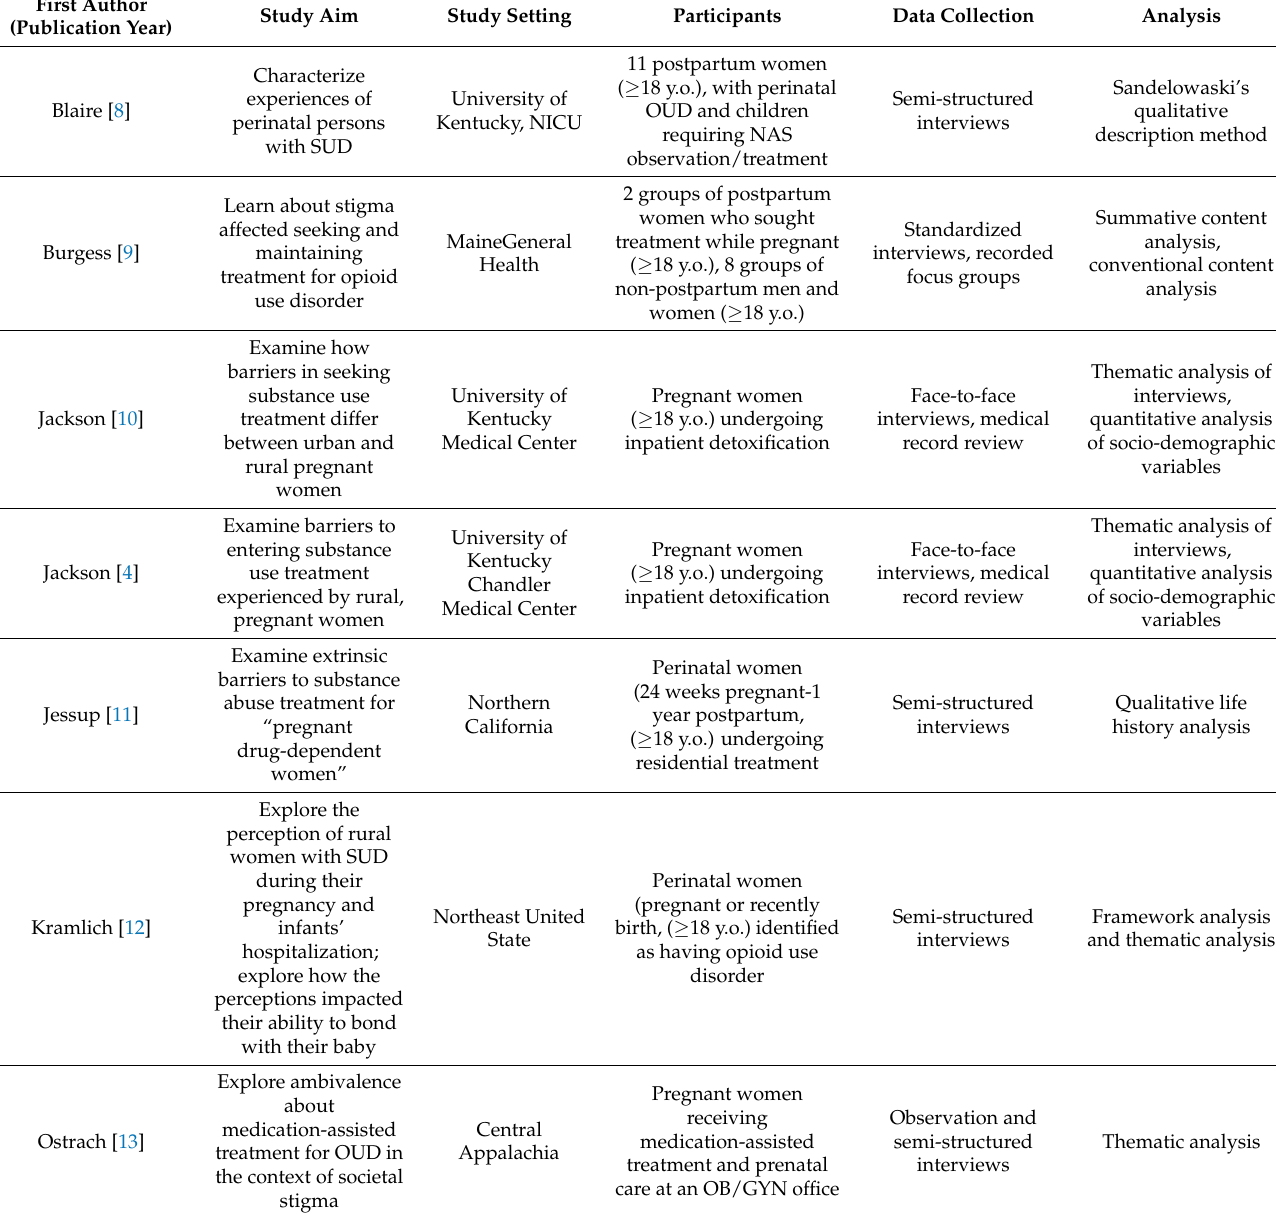
Table 1. Characteristics of the selected literature reviewed. Substance use disorder—SUD.